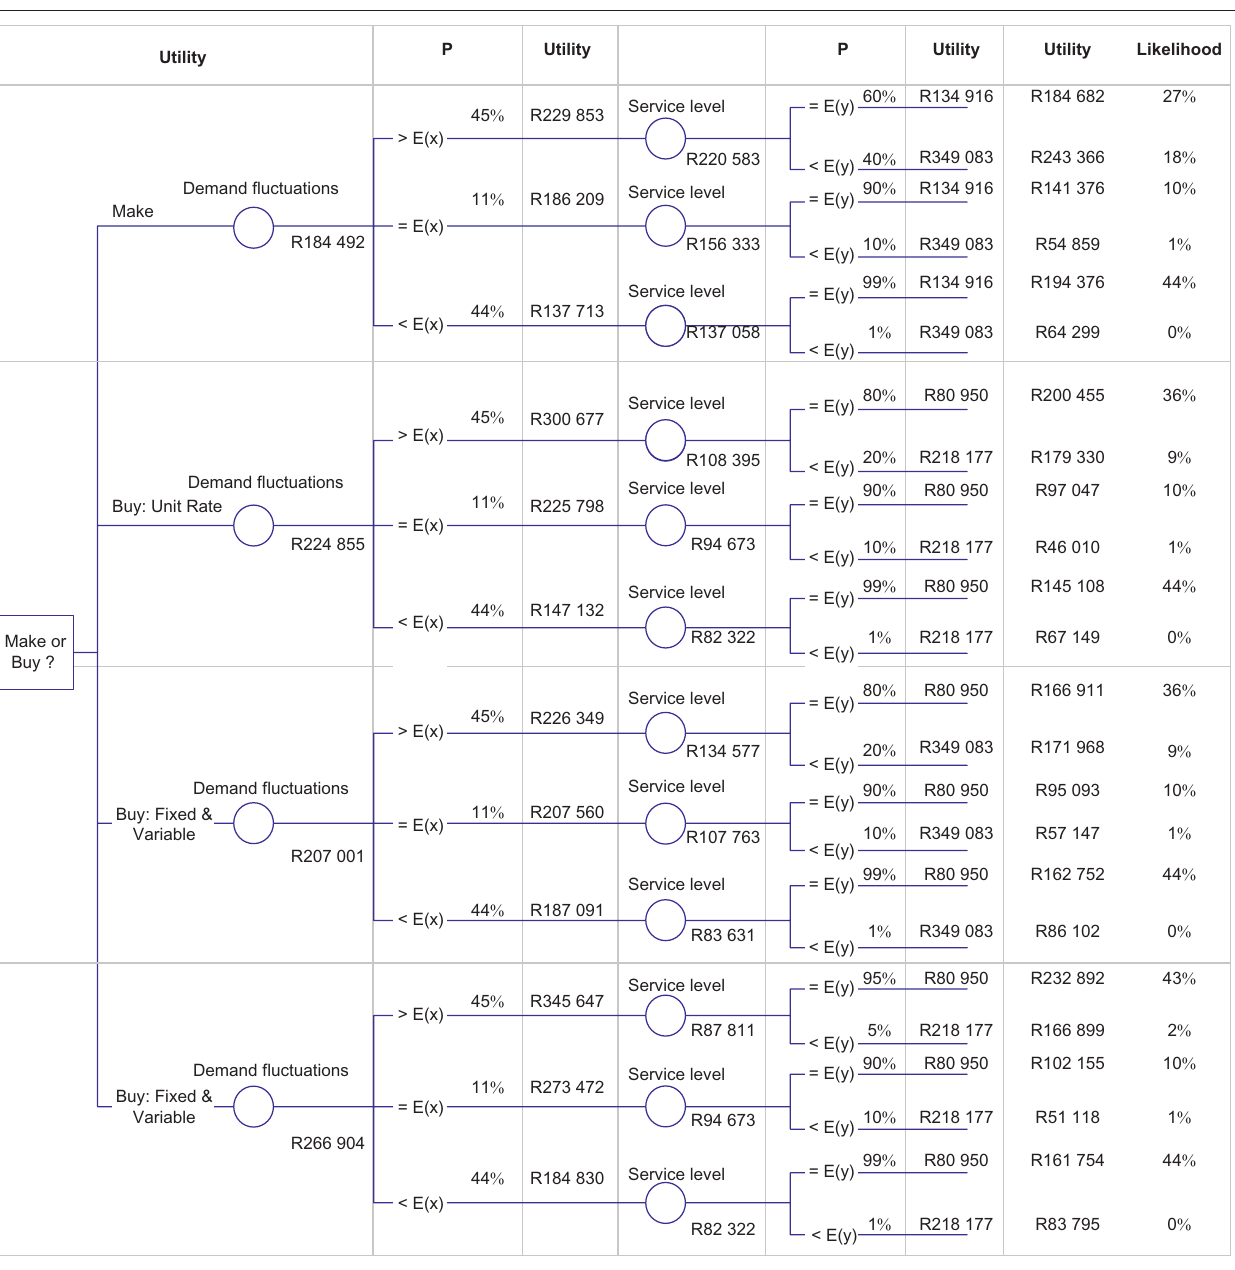
FIGURE 5: Decision